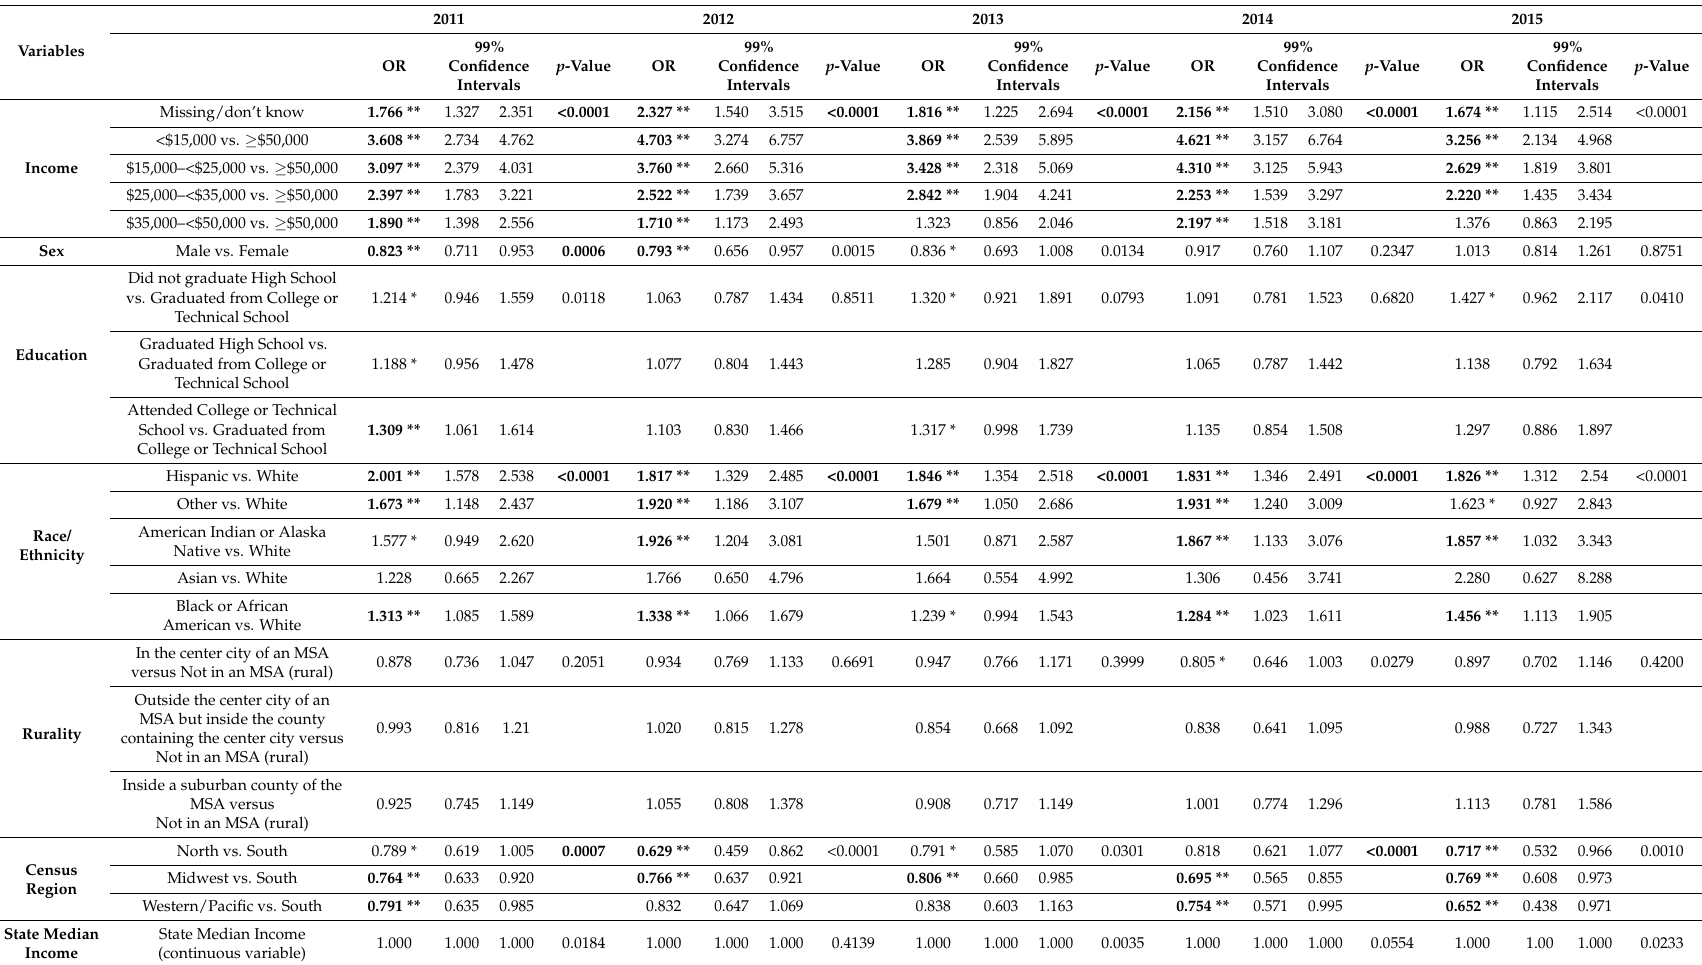
Table 5. Adjusted analysis for forgone medical care among those diagnosed with